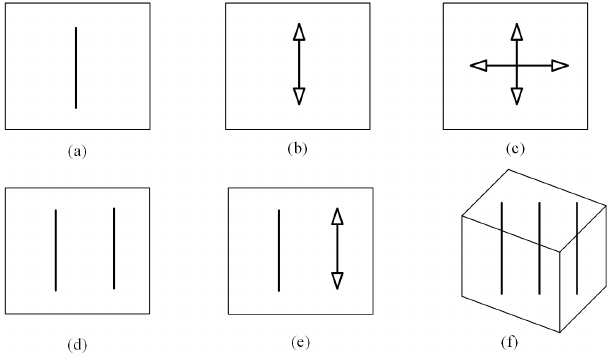
Figure 4. All possible sub-constraint spaces. (a) Single-force con- straint. (b) Single torque constraint. (c) Two torque constraints. (d) Two-force constraints. (e) One-force constraint and one torque con- straint. (f) Three-force